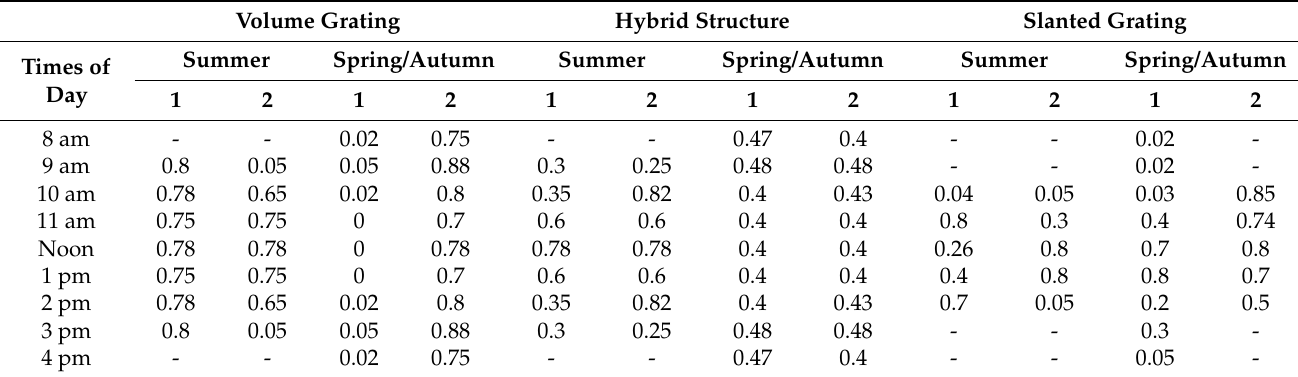
Table 2. Efficiency of different types of structures taking into account the trajectory of the Sun for Sochi during the spring–autumn